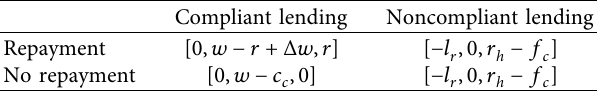
Table 3: Utility matrix if the society chooses not to set up the